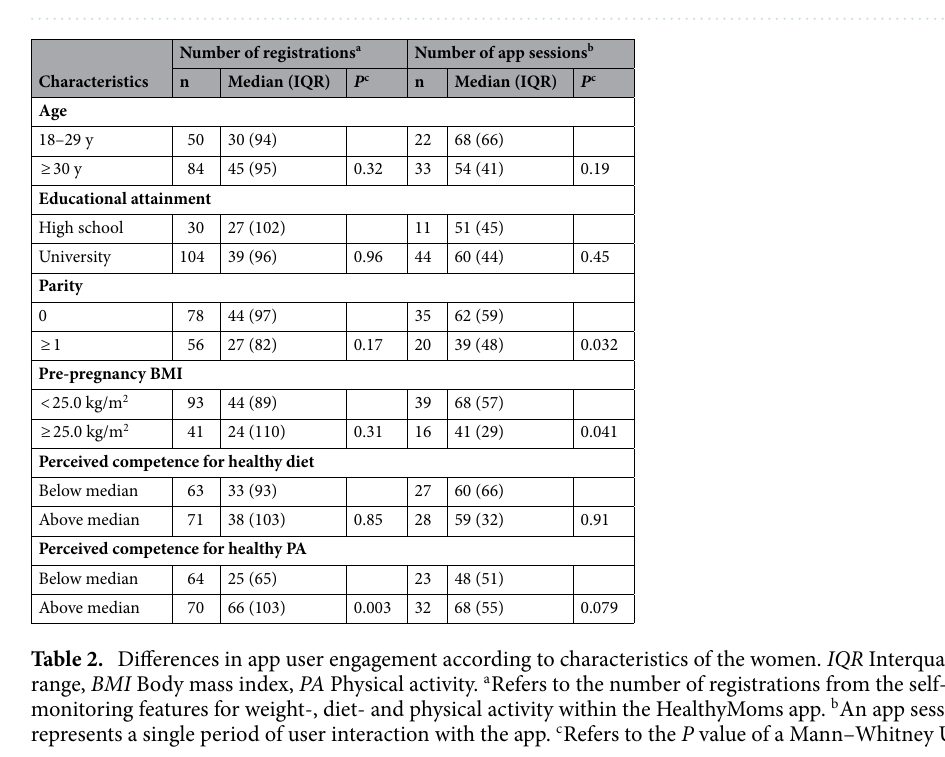
Figure 2. Number of registrations and app sessions per theme using box-and-whiskers plots. Registrations refers to the total number of registrations from the self-monitoring features for weight-, diet- and physical activity within the HealthyMoms app whereas an app session represents a single period of user interaction with the app. The box visualizes values for the first quartile, median and third quartile whereas the whiskers represent the first quartile minus 1.5 times the interquartile range and the third quartile plus 1.5 times the interquartile range. Each theme represents a two-week period.